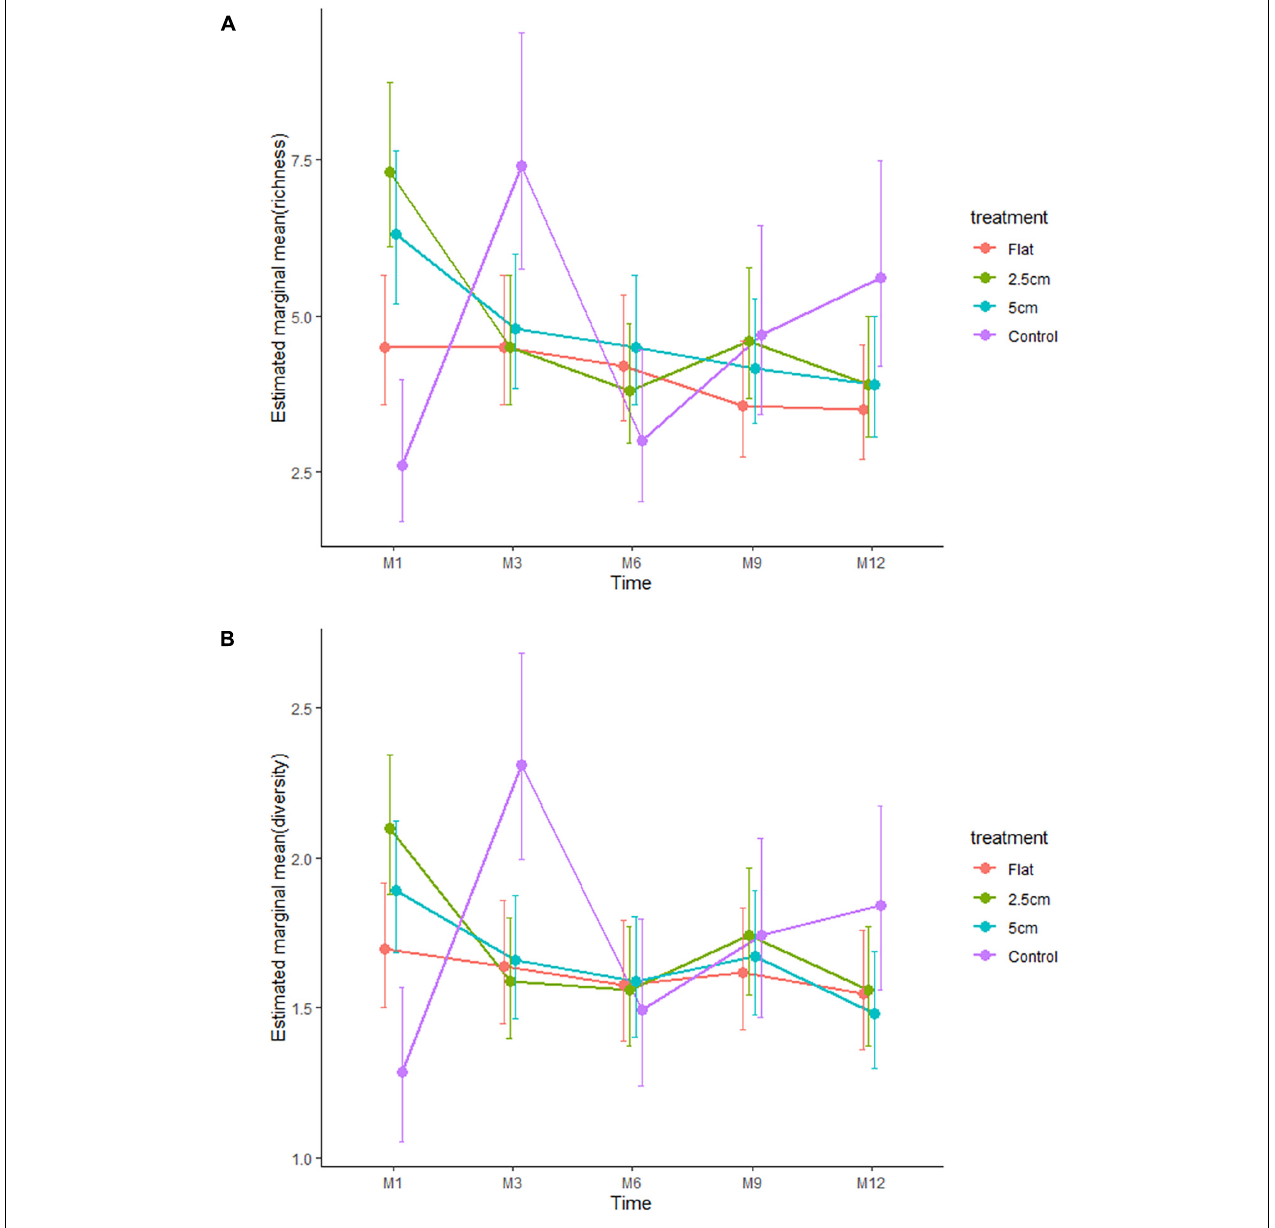
FIGURE 4 | Effects of physical complexity (pooled over unseeded and seeded treatments at both sites) on the (A) mean taxa richness and (B) mean diversity (Shannon index) of the recruited sessile organisms at each time point. Note that the lower and upper errors are absolute